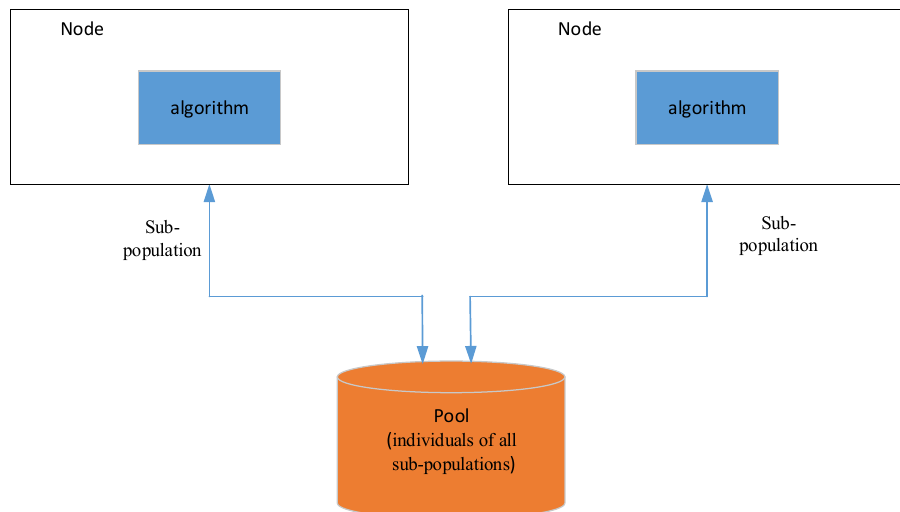
Figure 8. Communication between nodes in improved Pool model.